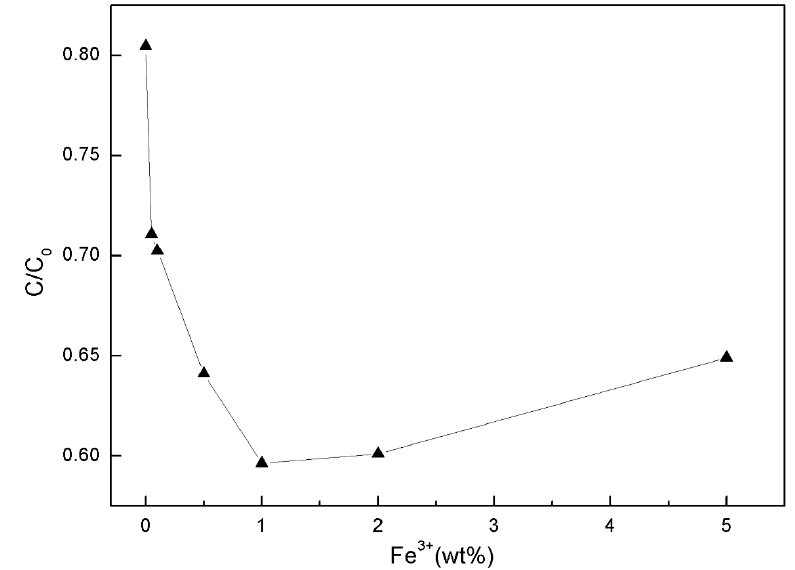
Figure 10. Effect of Fe 3+ doping on the degradation of methyl orange by STCF.